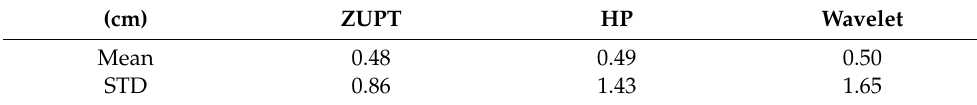
Table 2. Mean and standard deviation of error after different drifts correction